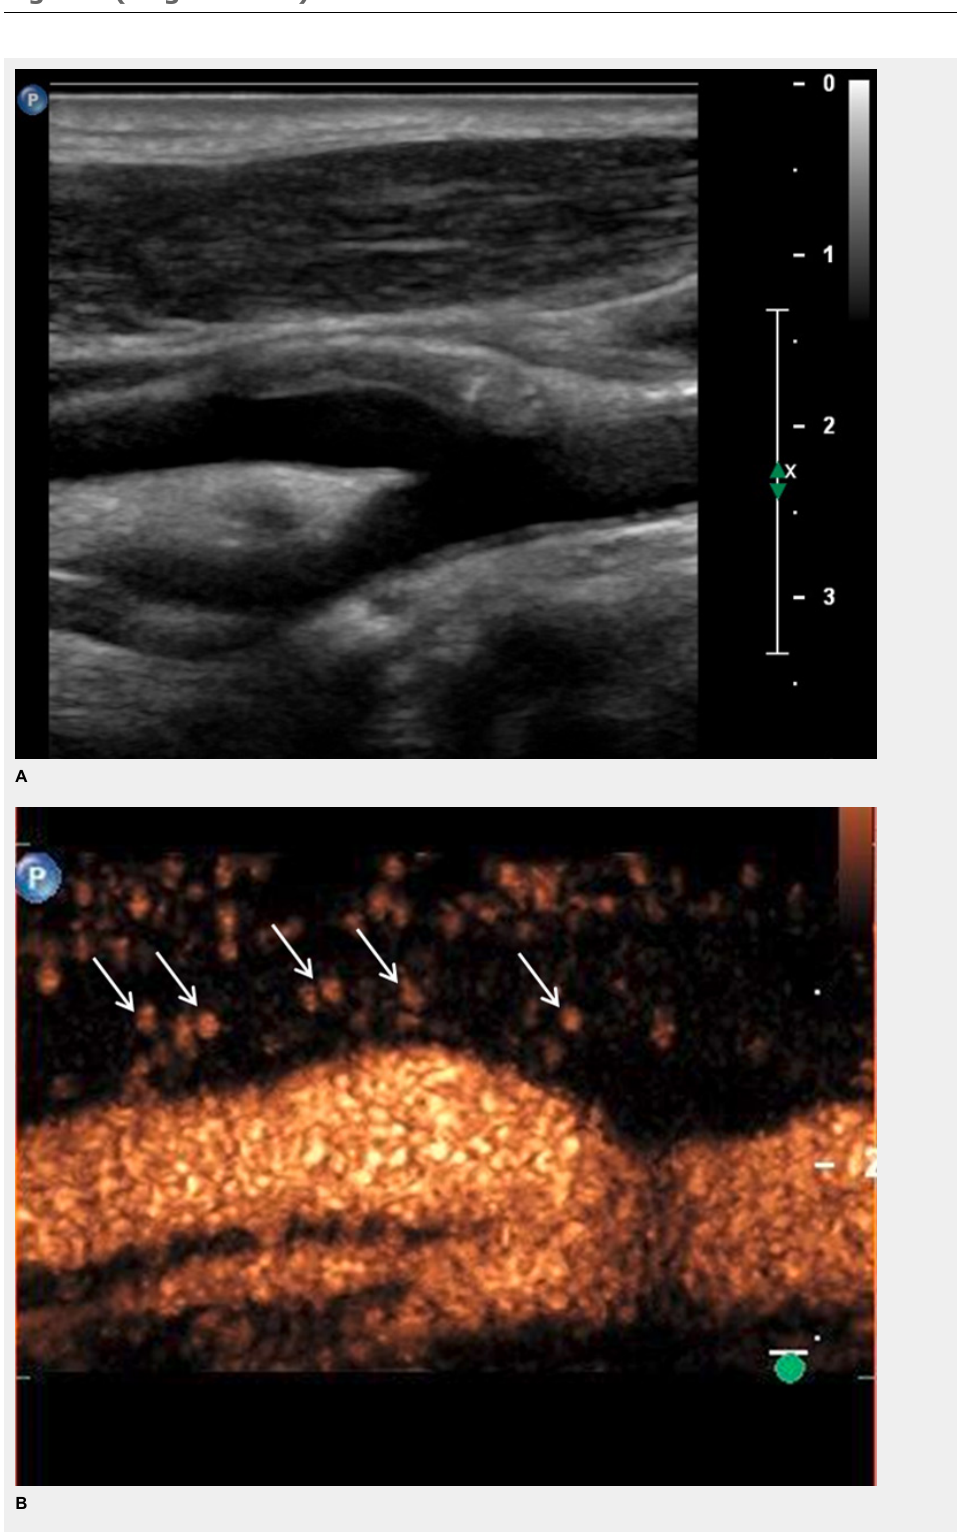
A 58-year-old patient with myocardial infarction 2 months previously with hypoechogenic plaque at the origin of the left internal carotid artery on B-mode ultrasound (A). Extensive intraplaque neovascularisation (arrows) on CEUS imaging